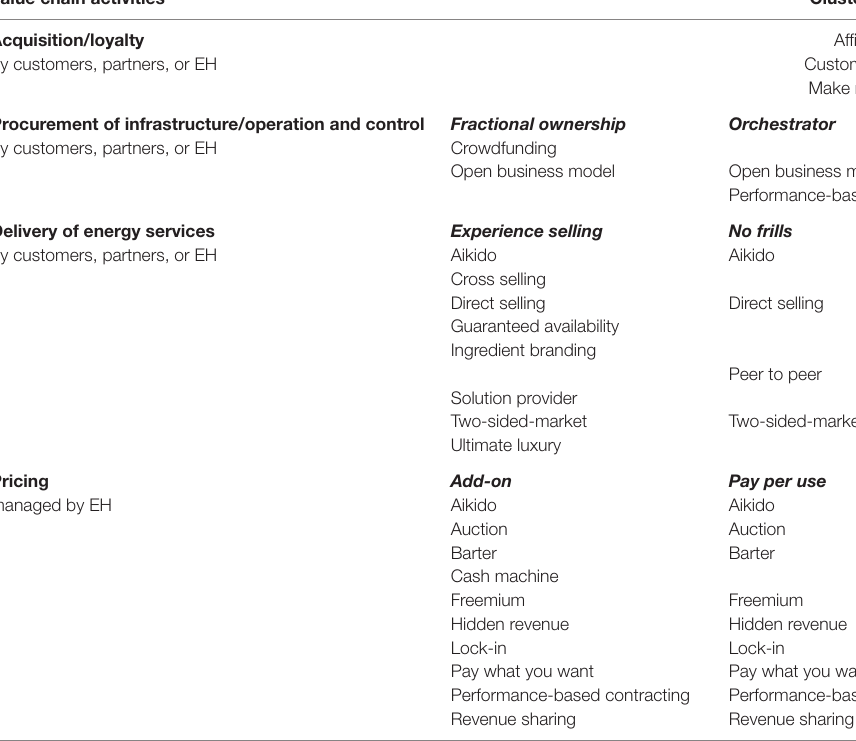
TaBle 2 | clusters of business model ideas.